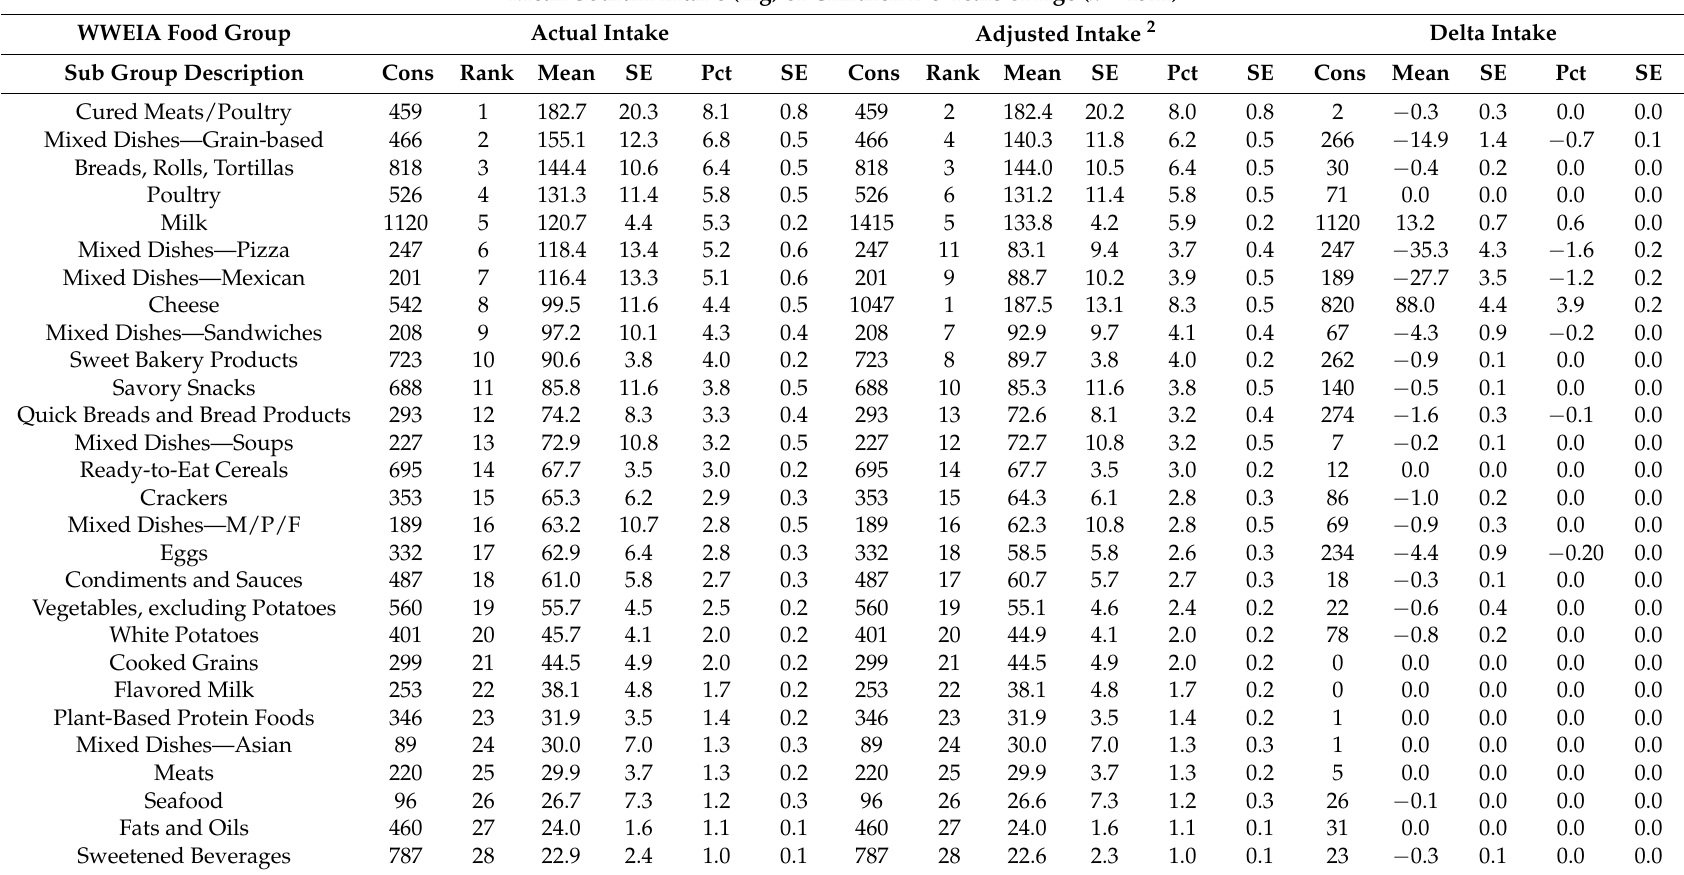
Table 8. Food/food group sources 1 of mean sodium (mg) intake among US children aged 2–18 years ( N = 5876): National Health and Nutrition Examination Survey